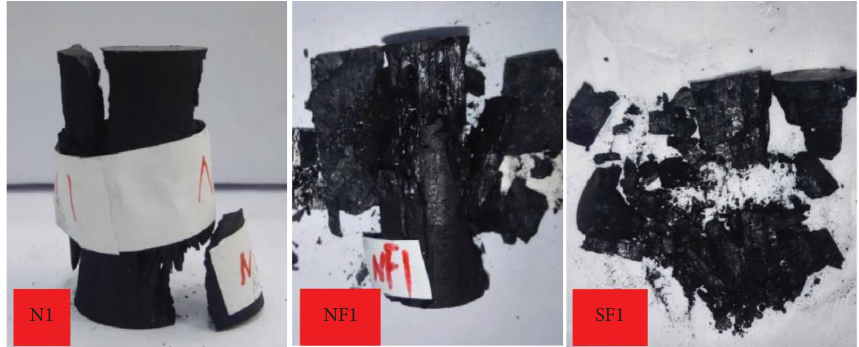
Figure 4: Coal sample failure patterns under diferent